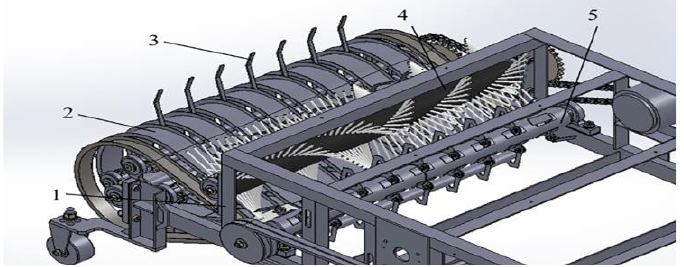
Figure 1. The working mechanism of the returning machine (1: door frame; 2: guard plate; 3: elastic teeth roller picking mechanism; 4: conveying brush roller; 5: cutting knife roller).